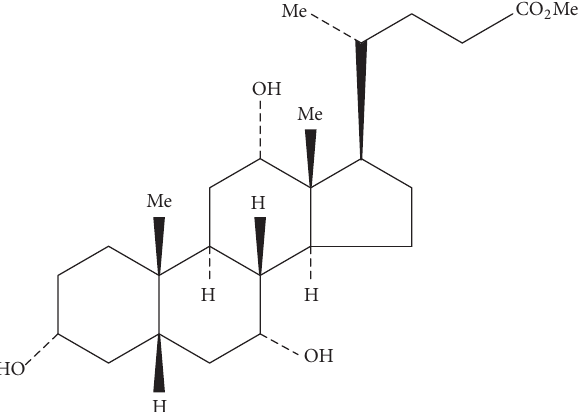
Figure 3: Methyl cholate structure (MC).